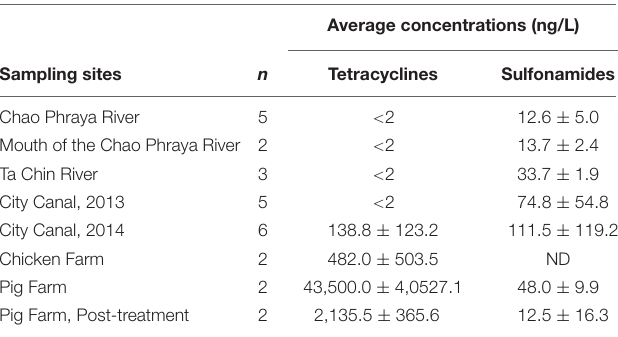
TABLE 2 | The average concentrations of tetracyclines and sulfonamides at the aquatic environments examined in this study.